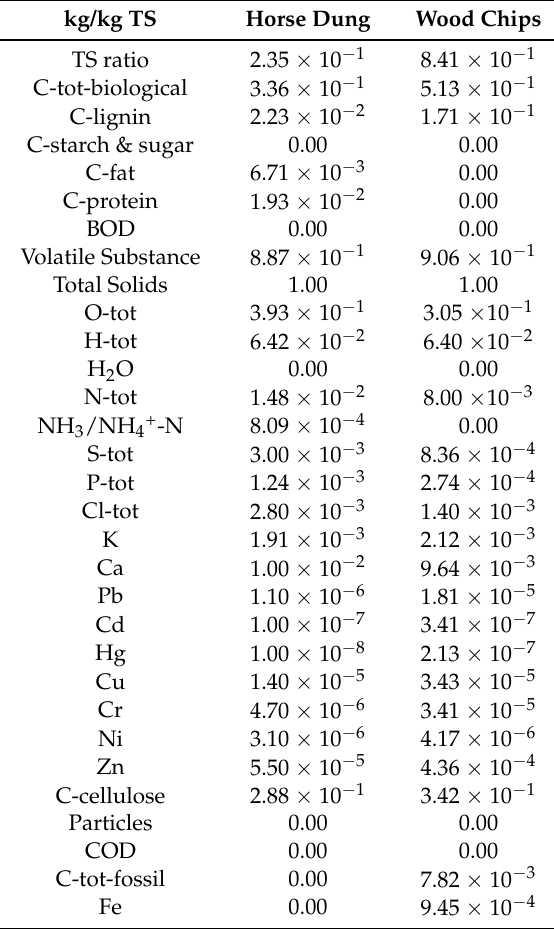
Table A1. Chemical composition of horse manure and bedding. References to data are found in [22]. BOD: Biological Oxygen Demand; and COD: Chemical Oxygen